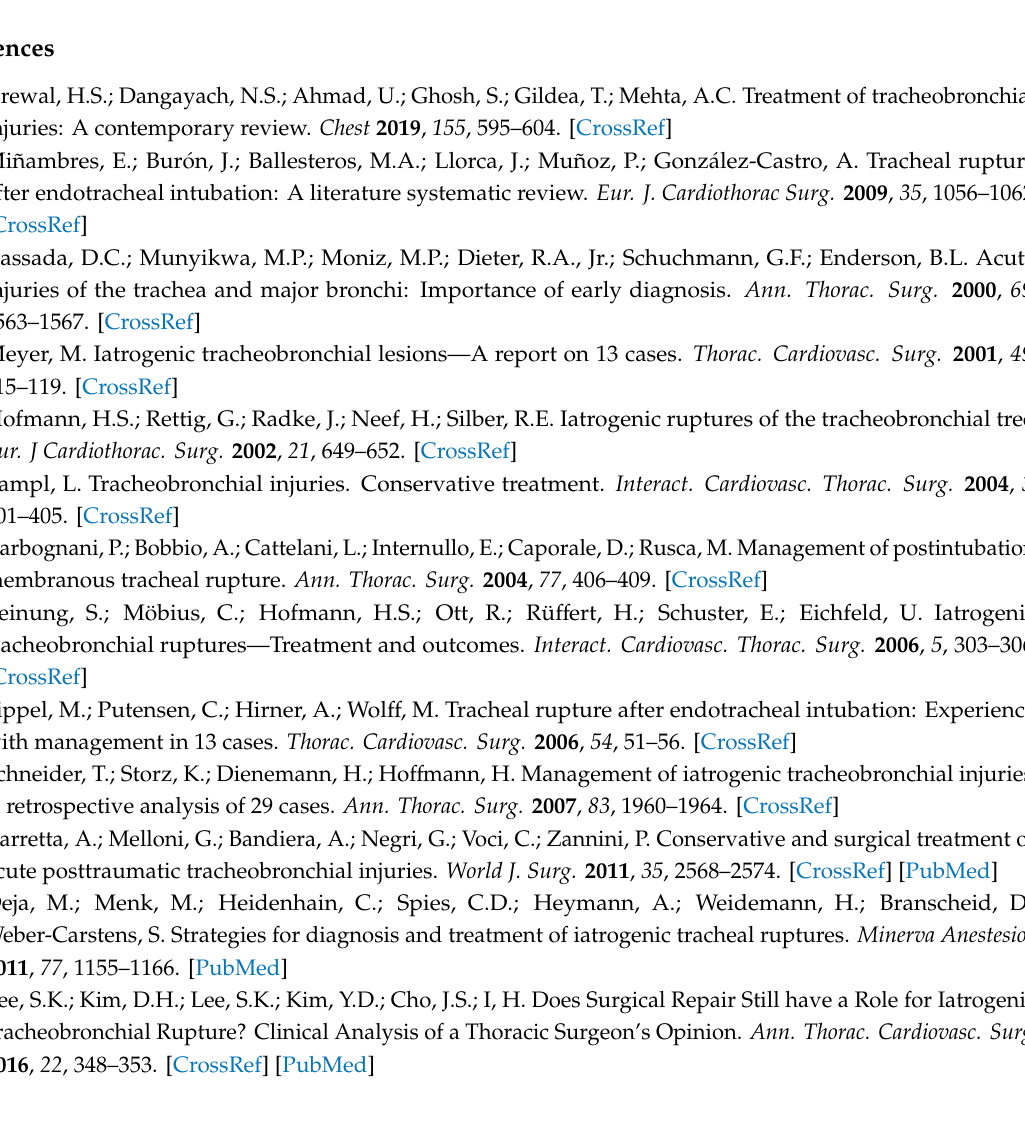
Table S1: Raw data